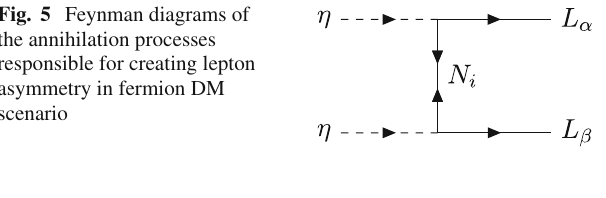
Fig. 4 Feynman diagram for inelastic scattering of scalar DM off nucleon mediated by Z boson